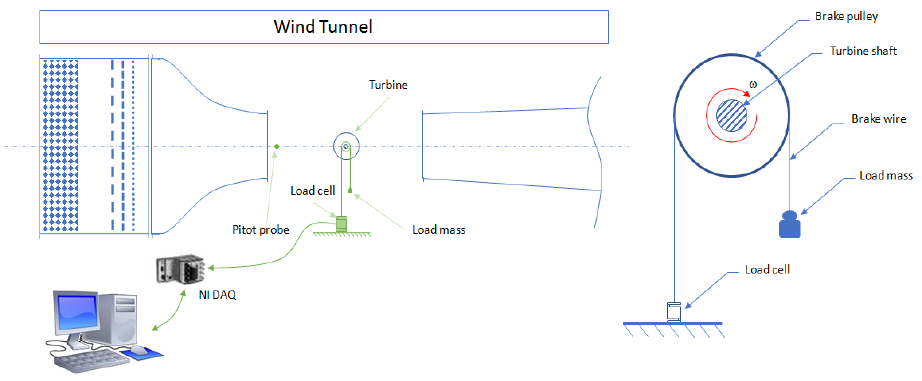
Figure 2. Experimental setup and detail of the mechanical brake system.